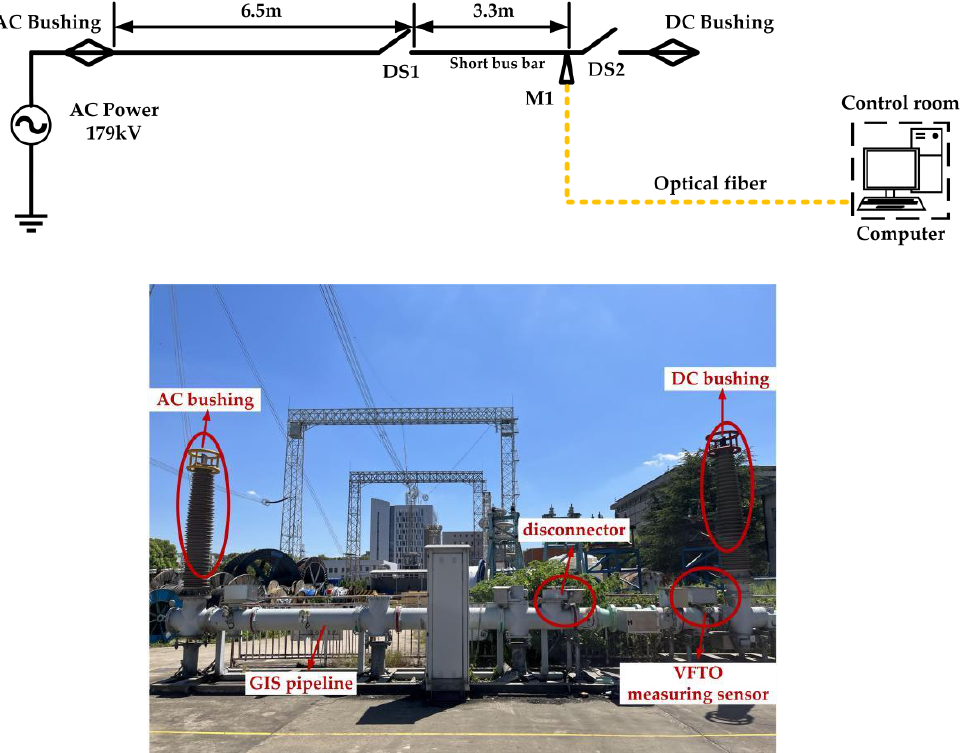
Figure 10. Schematic diagram of the 220 kV GIS test circuit.